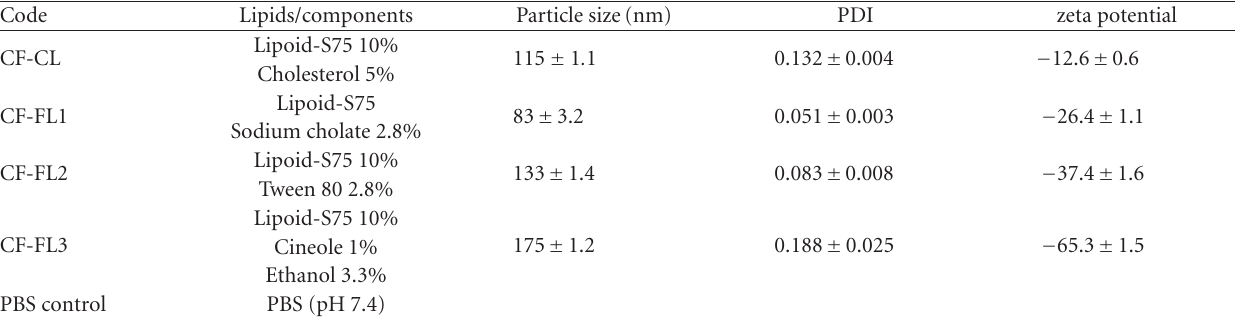
Table 1: Composition of the di ff erent types of liposomes and PBS